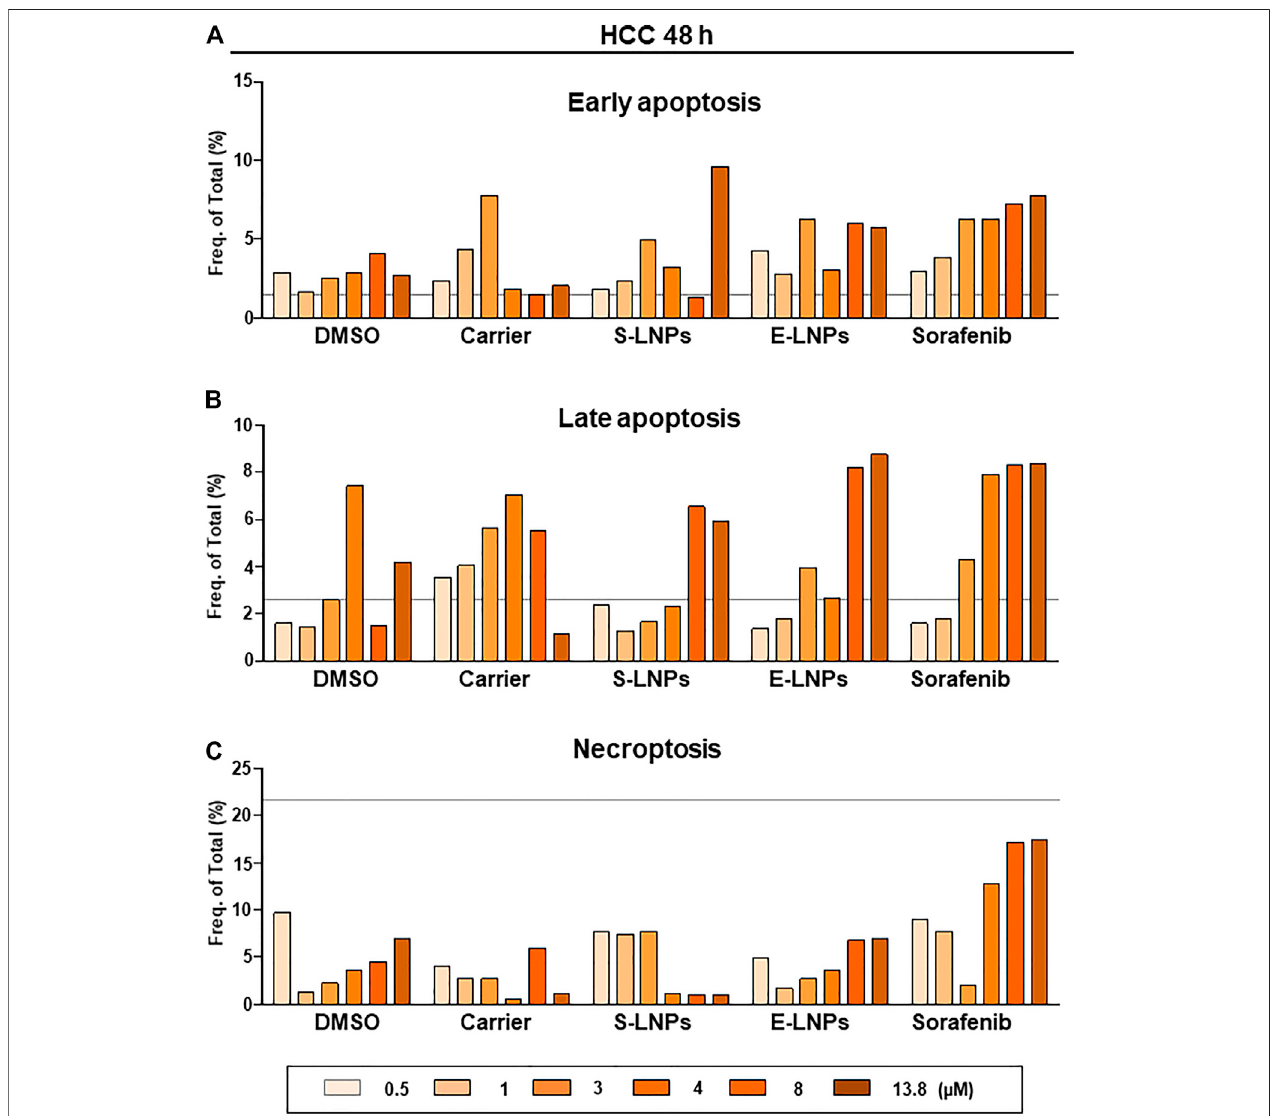
FIGURE8| FACSanalysisperformed48 haftertheincubationwithE-LNPscon fi rmedtheinductionoflateapoptosisandnecroptosisintheE-LNP-treatedgroup. FACSanalysistodetect (A) earlyand (B) lateapoptosisand (C) necroptosiswasperformedingroupstreatedwithS-LNPandE-LNPfractionsandstandardtherapeutic sorafenib using the gating strategy depicted in Supplementary Figure S14 . Shown are frequencies of (A) early and (B) late apoptotic and (C) necroptotic cells in percent. The gray line represents the values for the control group DMEM.